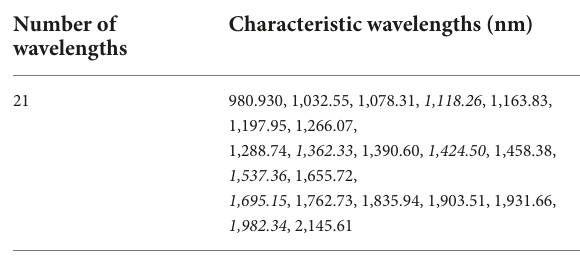
Figure 8 is a pseudo-color image of a penicilliosis navel orange sample synthesized by ICA03, ICA04, and ICA05.